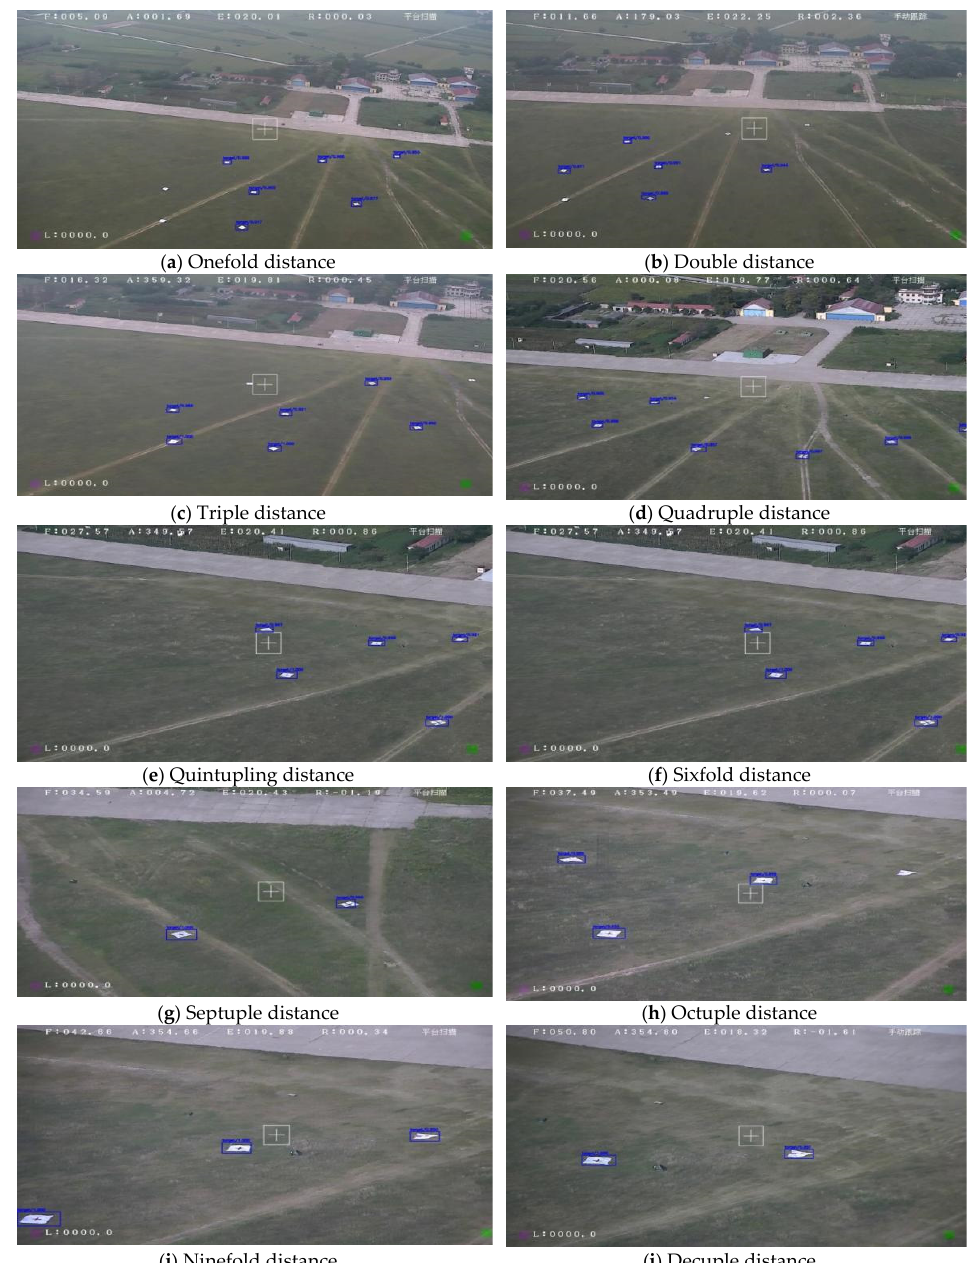
Figure 19. Target detection results under change of focal